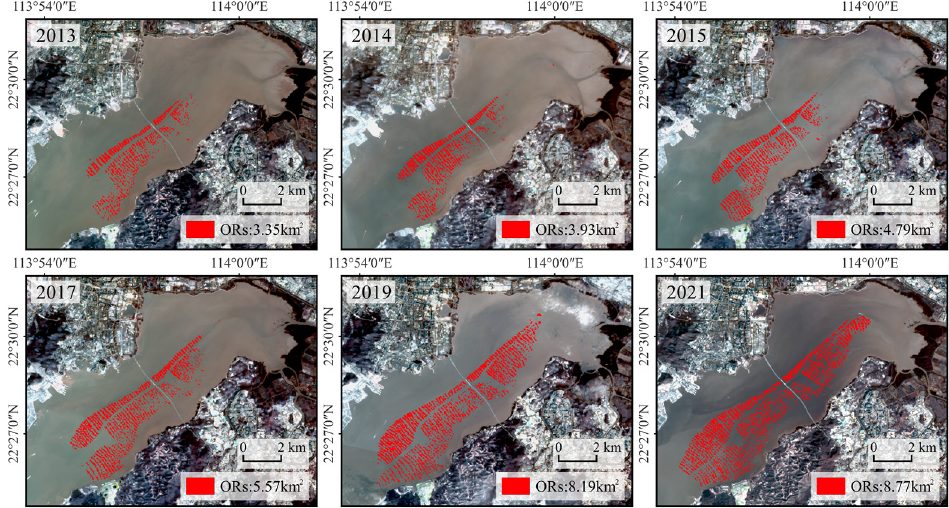
Figure 11. Inter-annual changes of the location and distribution of oyster rafts (ORs) in the Shenzhen Bay from 2013 to 2021.